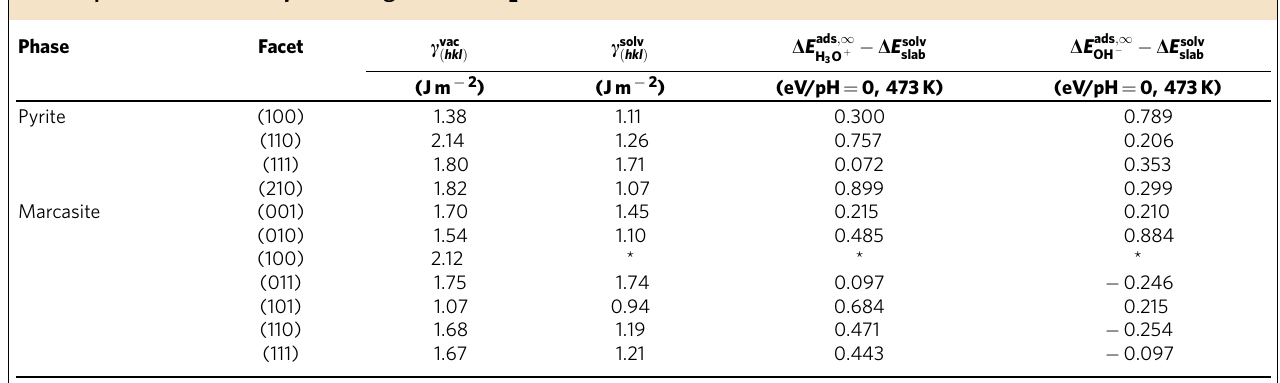
Table 1 | Surface and adsorption energetics of FeS 2 in water.